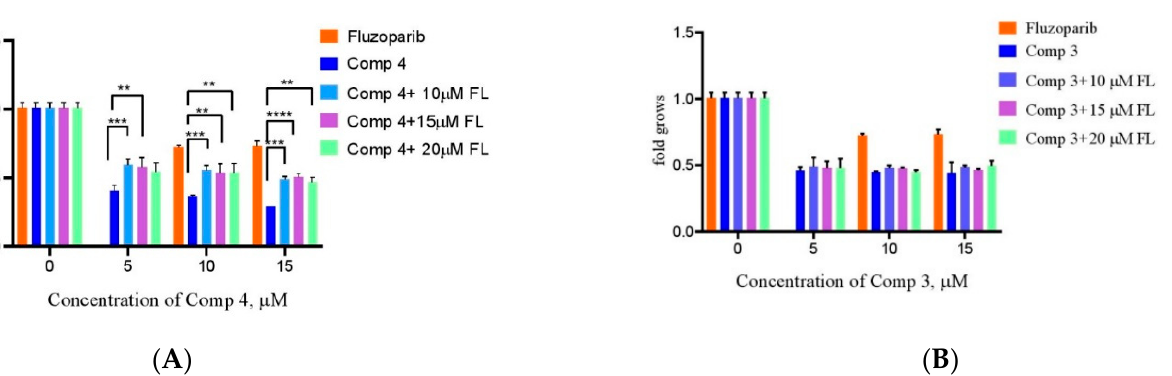
Figure 17. Preincubation of MCF-7 cells with PARP1 inhibitor Fluzoparib decreased their sensitivity to the treatment with compounds 4 ( A ) and 3 ( B ). MTT data on 72 h of cells incubation with studied compounds 3 and 4 (** p < 0.01, *** p < 0.001, **** p < 0.0001).